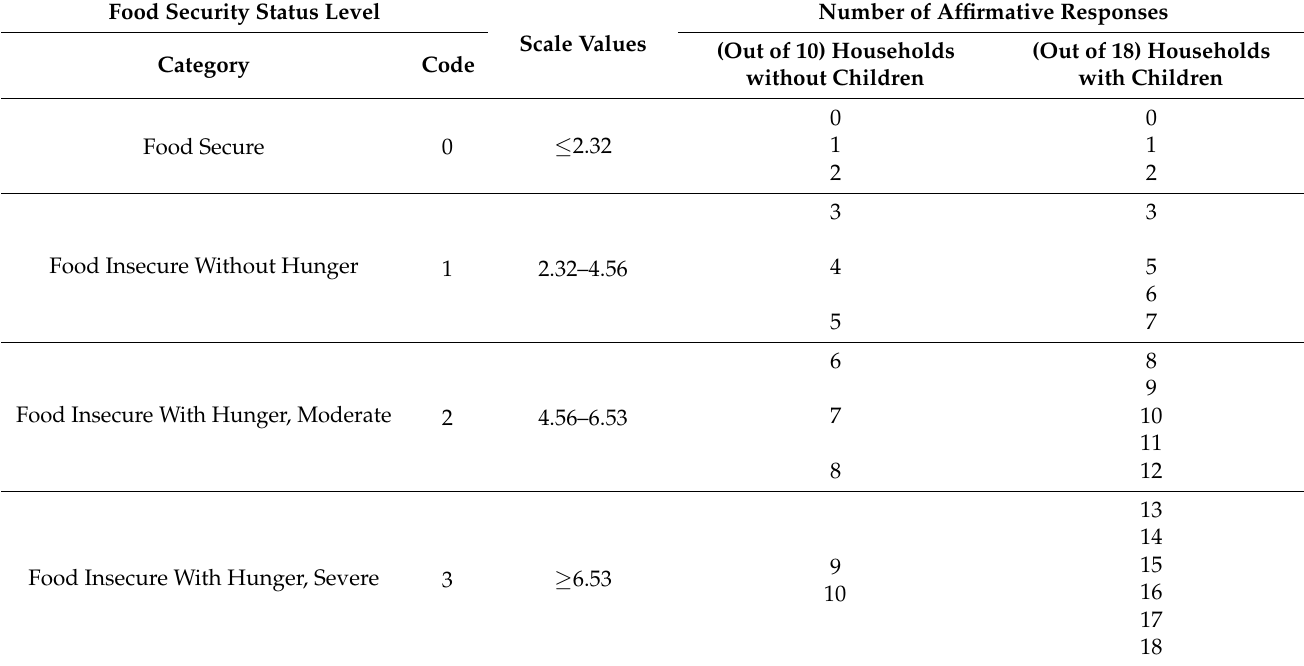
Table 1. Analysis of the food security situation in rural